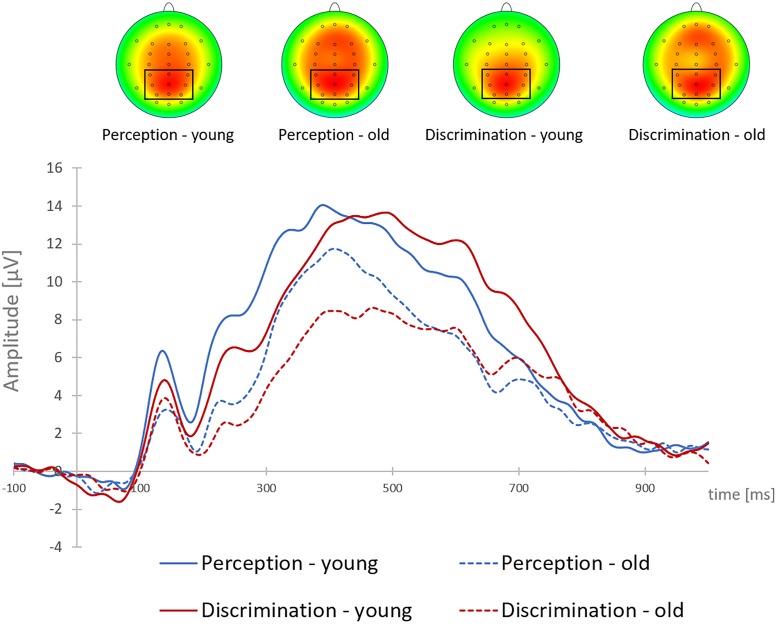
Grand-average target-locked P3b at Pz and P3b brain topographies to single brake lights, shown for young and older participants, and for the perception and discrimination tasks. The cluster of parietal electrodes for P3b analysis is marked.